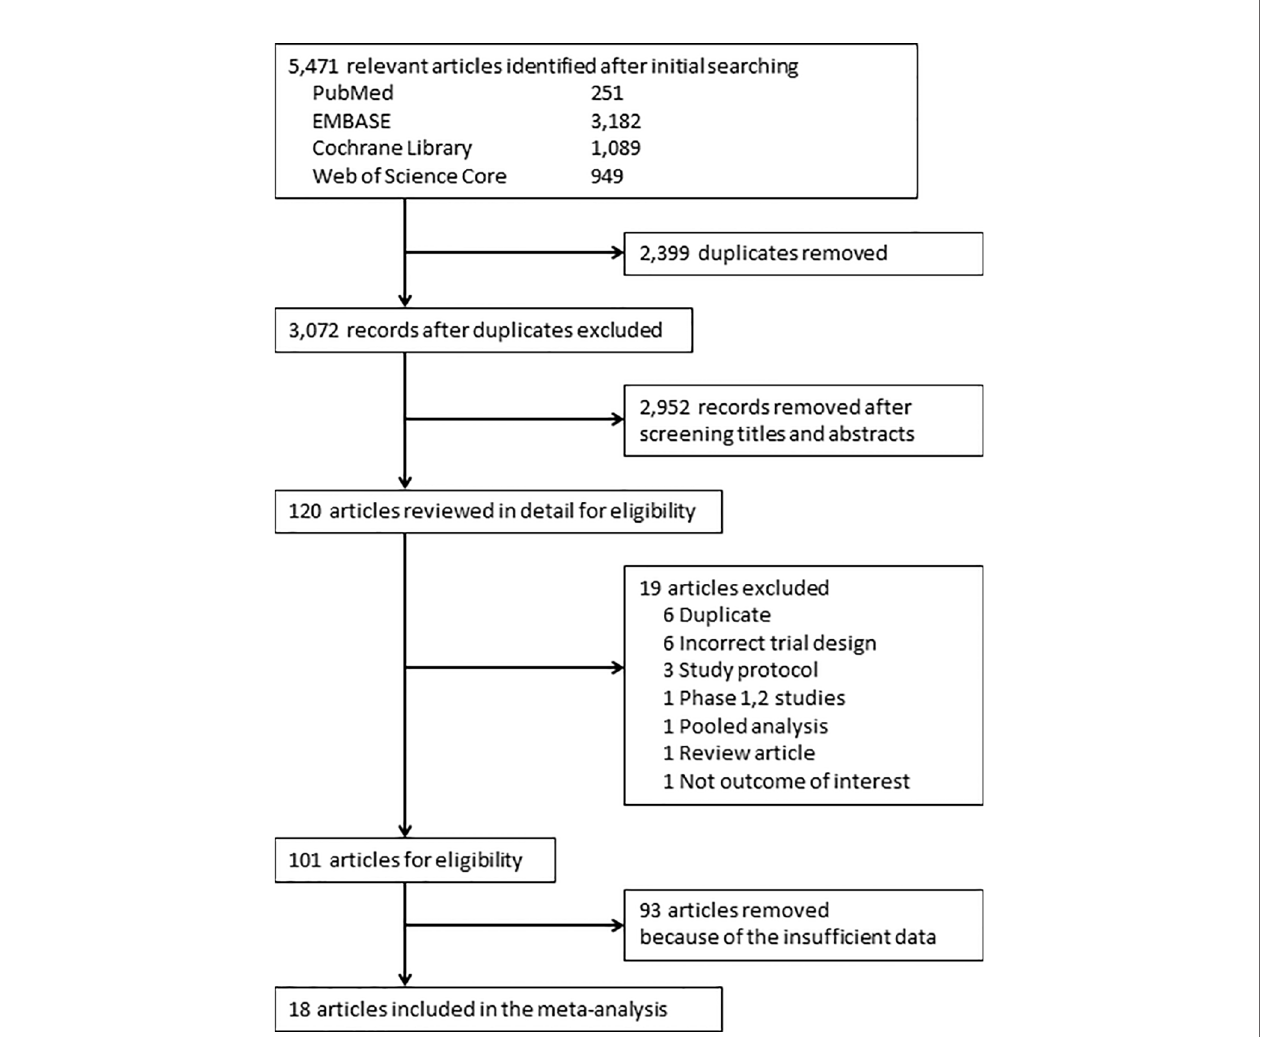
FIGURE 1 | PRISMA fl ow diagram for the meta-analysis. Study selection process according to the Preferred Reporting Items for Systematic Reviews and Meta- Analyses (PRISMA)